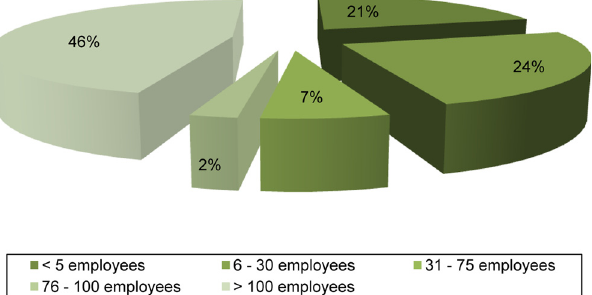
Figure 3. Composition